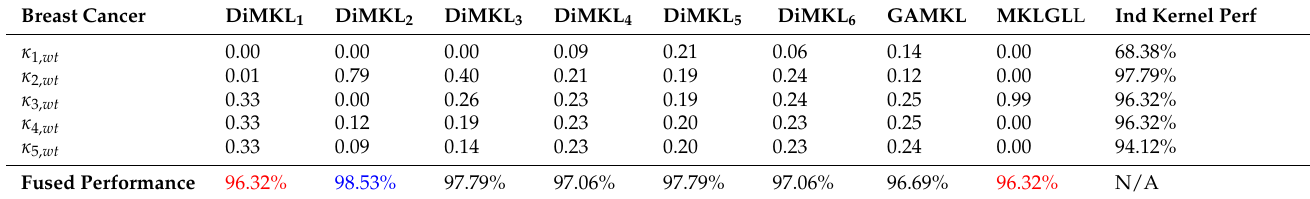
Table 9. Breast Cancer: highest performing method is shown in blue; lowest performing is shown in